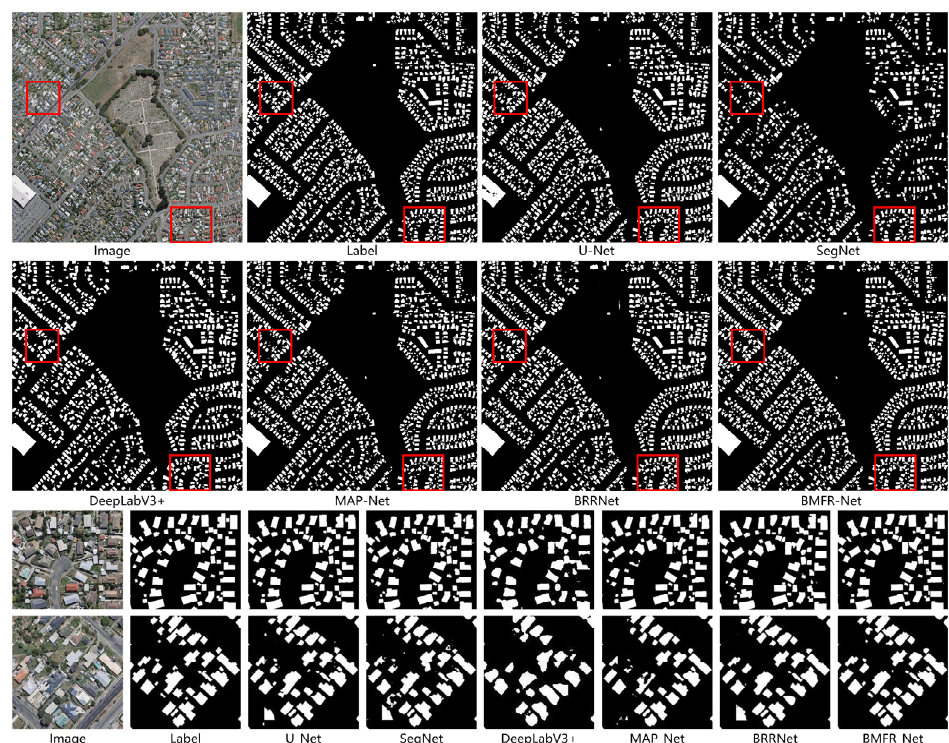
Figure 8. Extensive area building extraction results by different methods on the WHU Buildings Dataset. The bottom column represents the corresponding partial details.